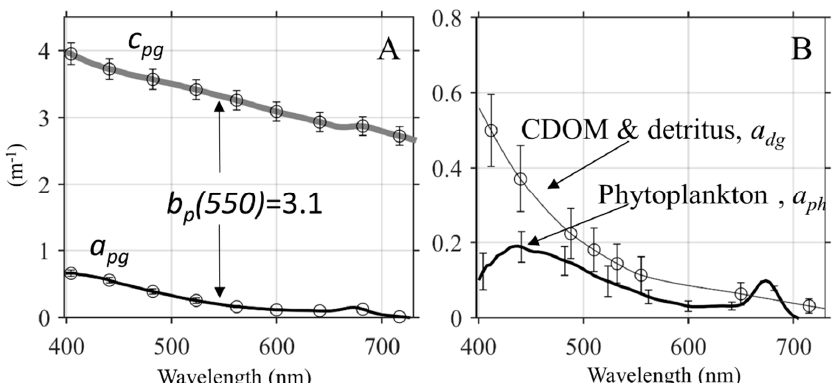
Figure 5. Field measurements near the West LOBO Buoy (Figure 1) made coincident with the overflights of ( A ) spectral attenuation ( c pg ), absorption ( a pg ) and particulate scattering ( b p ). ( B ) Absorption measurements were partitioned into that by phytoplankton ( a ph ) and colored dissolved and detrital matter ( a dg ) using coincident measurements of a g . The mean over approximately 1 h is shown with one standard deviation as error bars.